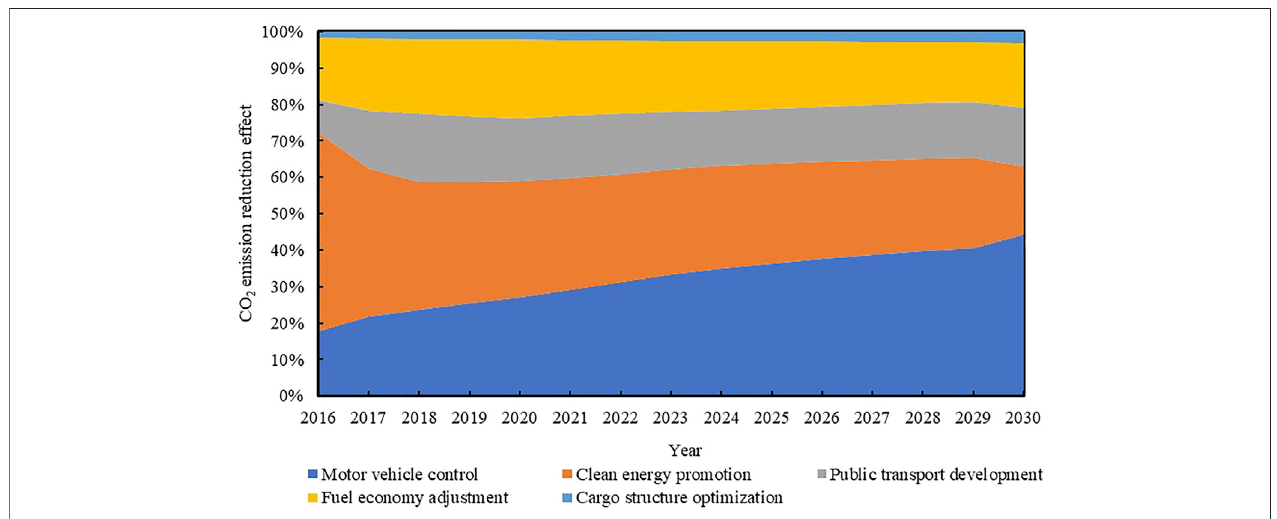
FIGURE 5 | Proportion of CO 2 reduction for different measures under a low-carbon scenario for the road and marine transportation sectors in Guangdong Province.